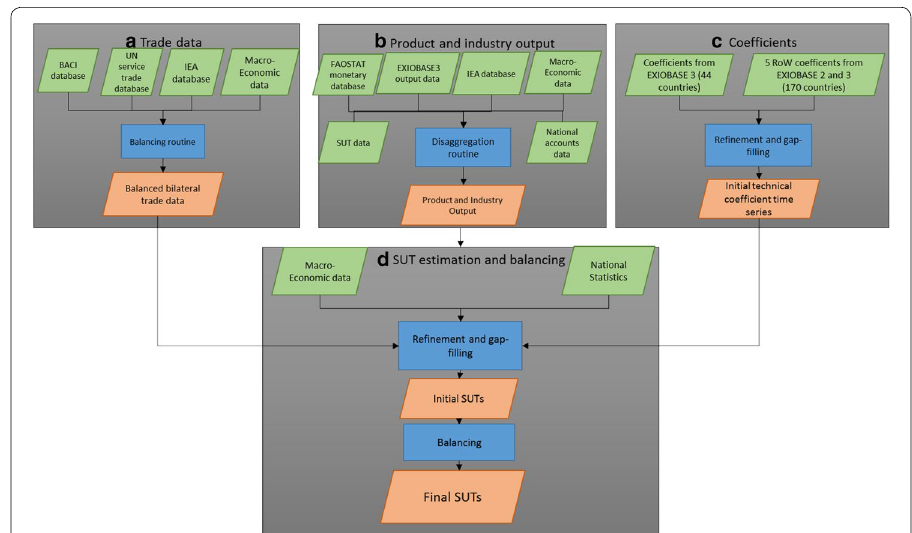
Fig. 1 EXIOBASE 3rx: compilation steps for monetary supply use tables. Approach based on figure in Stadler et al.